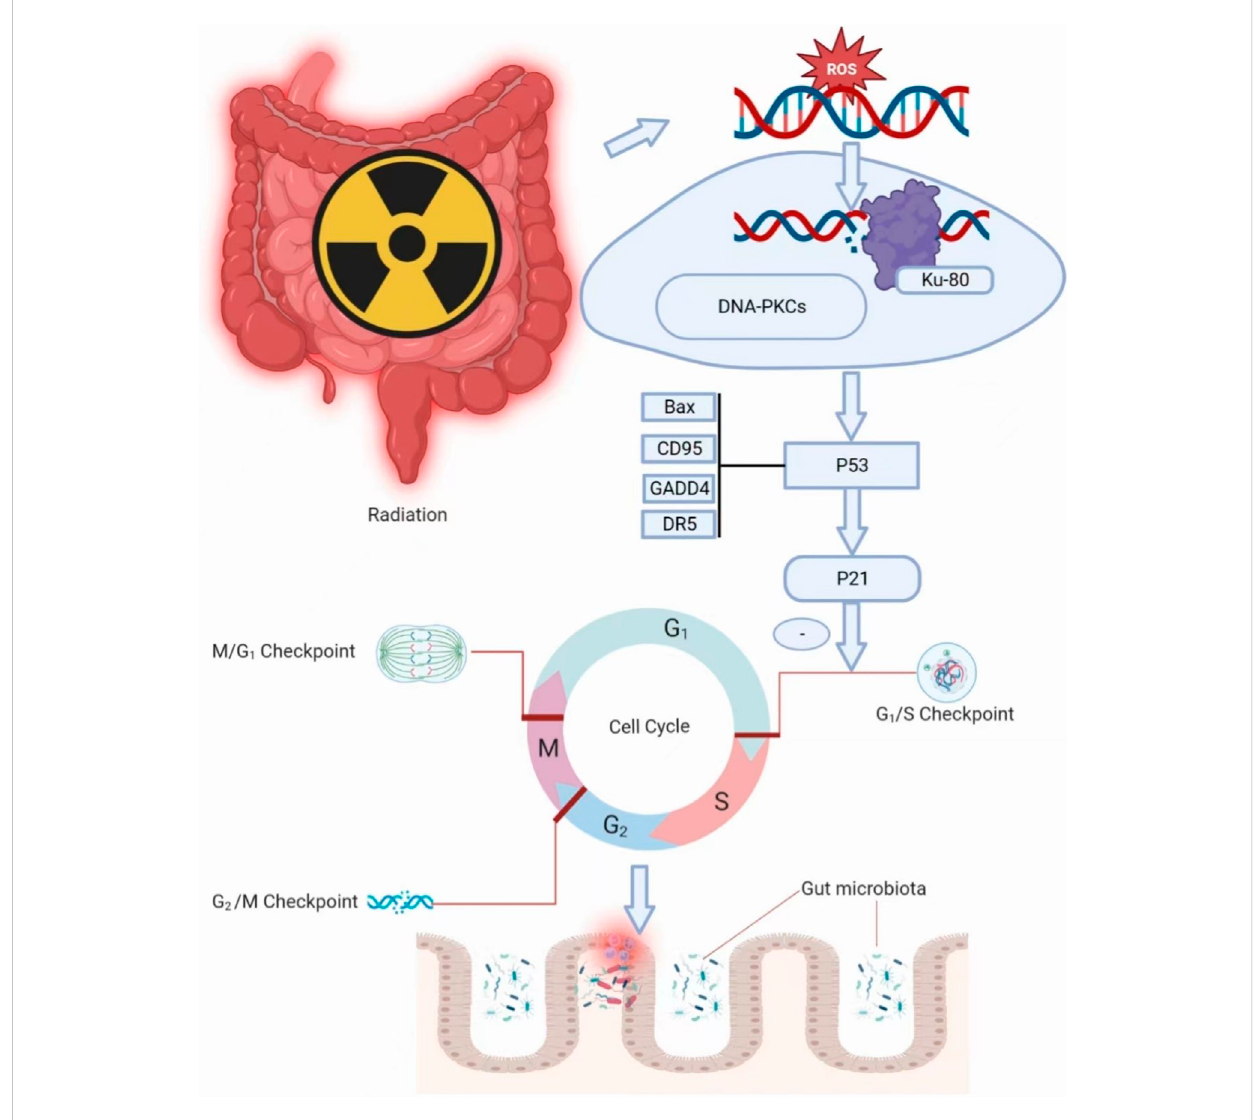
FIGURE 3 Irradiation damages intestinal